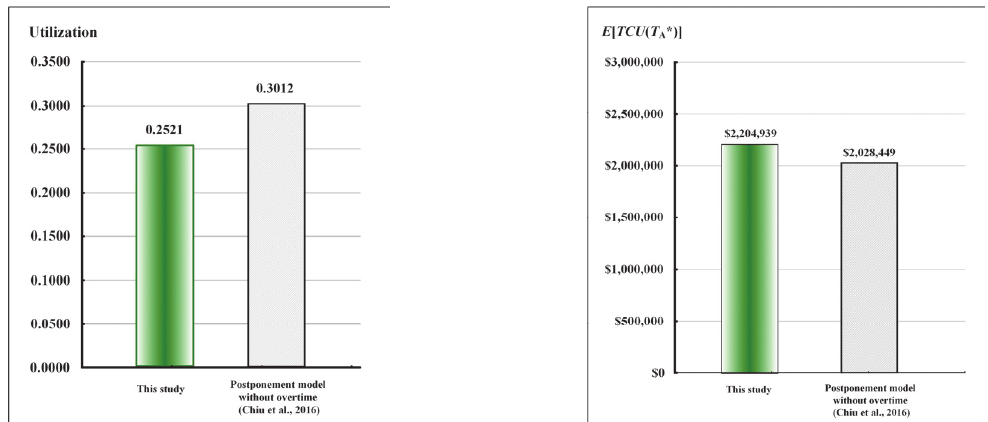
Fig. 13. Comparison of the utilization and E [ TCU ( T A *)] of this study with an existing